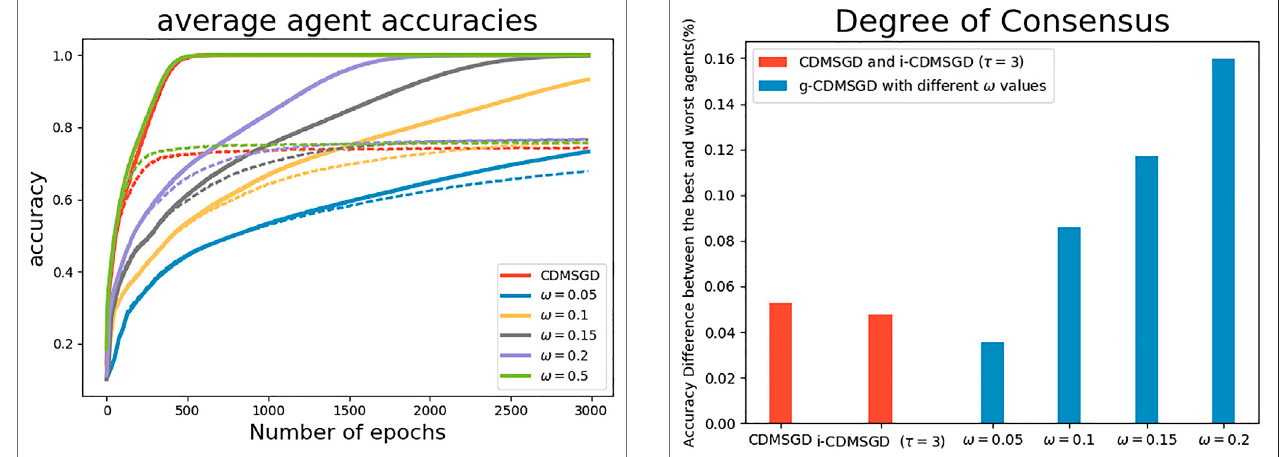
FIGURE 3 | Performance of g-CDMSGD for different ω values (Dashed lines represent test accuracy and solid lines represent training accuracy.)